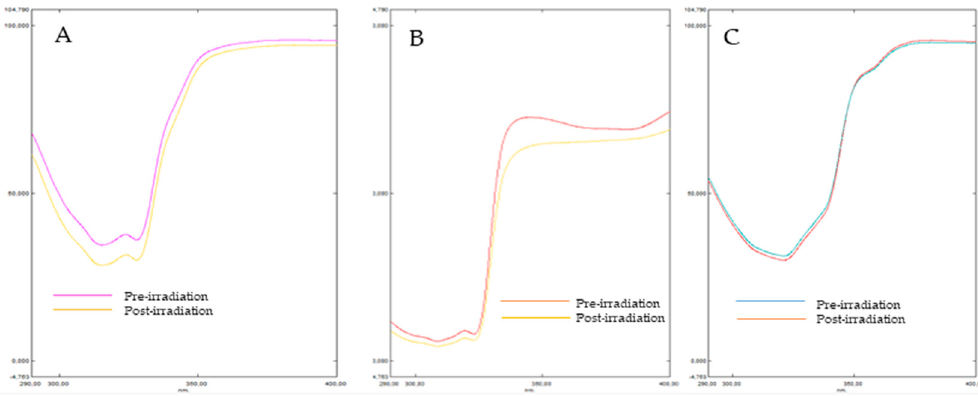
Figure 2. Transmittance profiles of formulations studied containing the benzimidazole derivatives 10 (panel A ), 11 (panel B ) and 12 (panel C ) (1% w / w ).